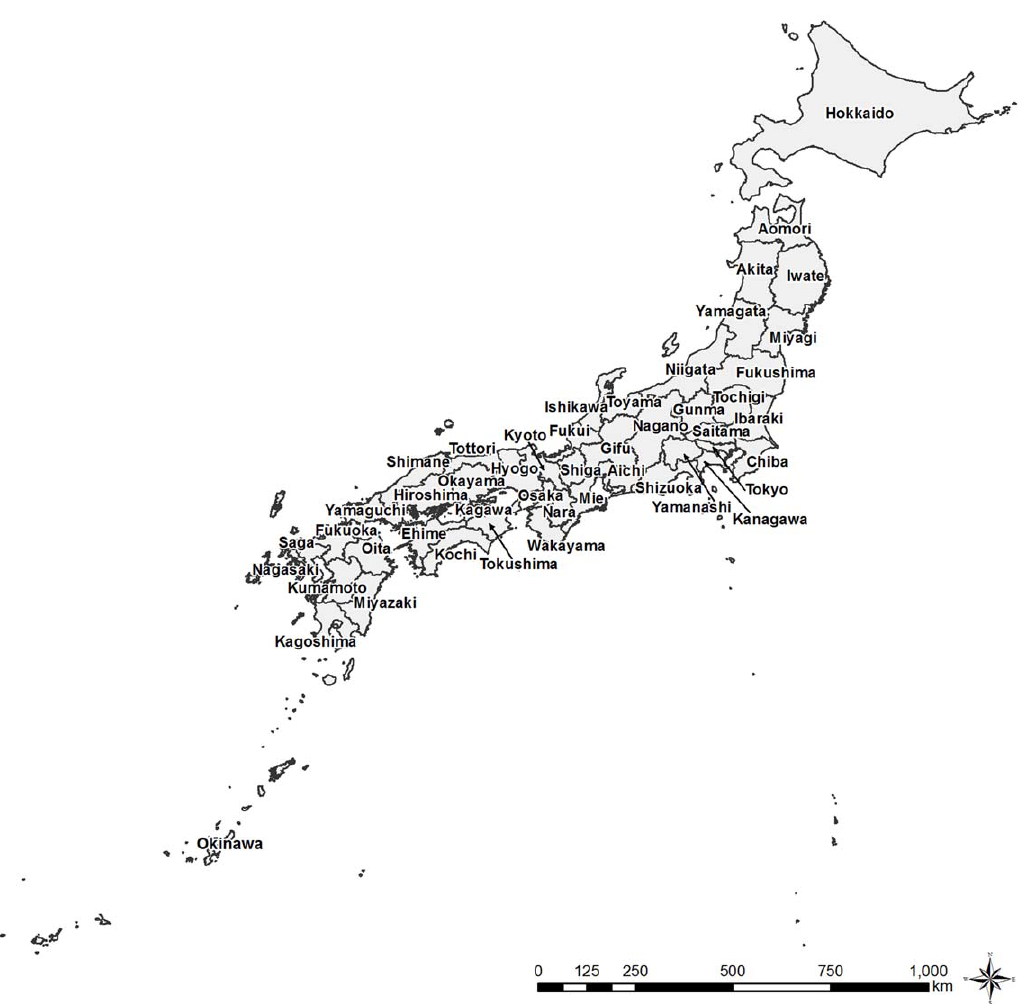
Figure 1. A blank map of Japan. We show the locations of 47 prefectures in Japan.